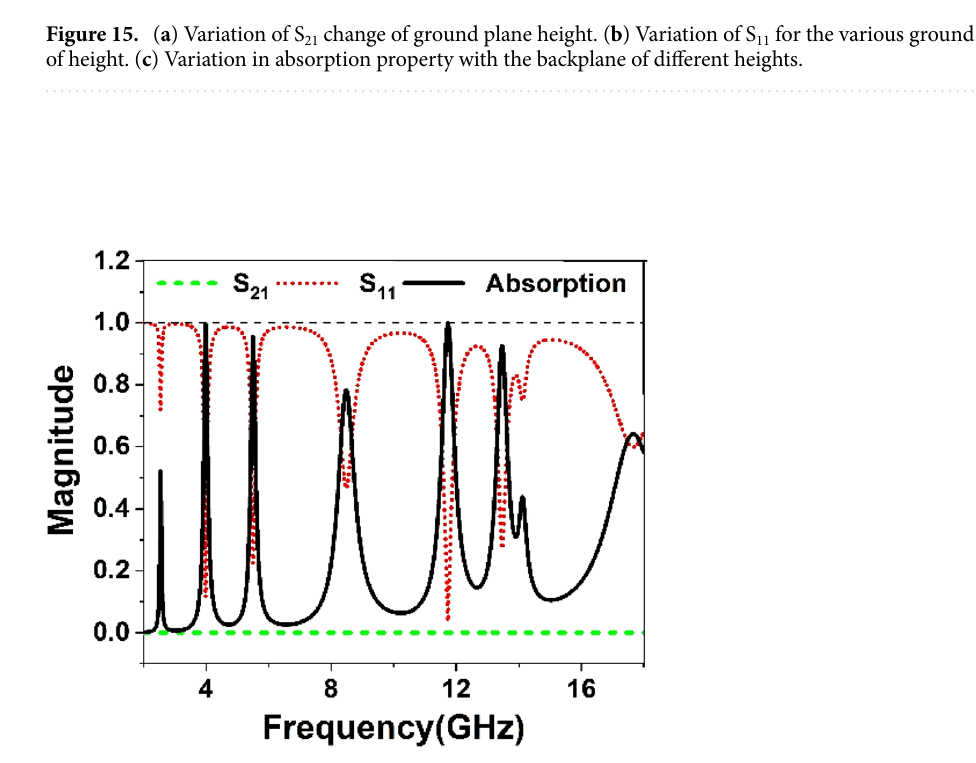
Figure 16. S 21 , S 11, and absorption plot for full copper